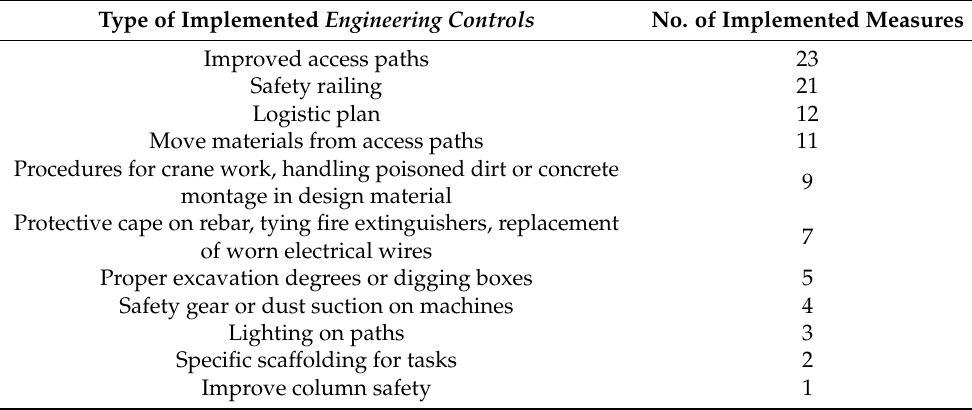
Table 2. Subcategories of successfully implemented engineering controls